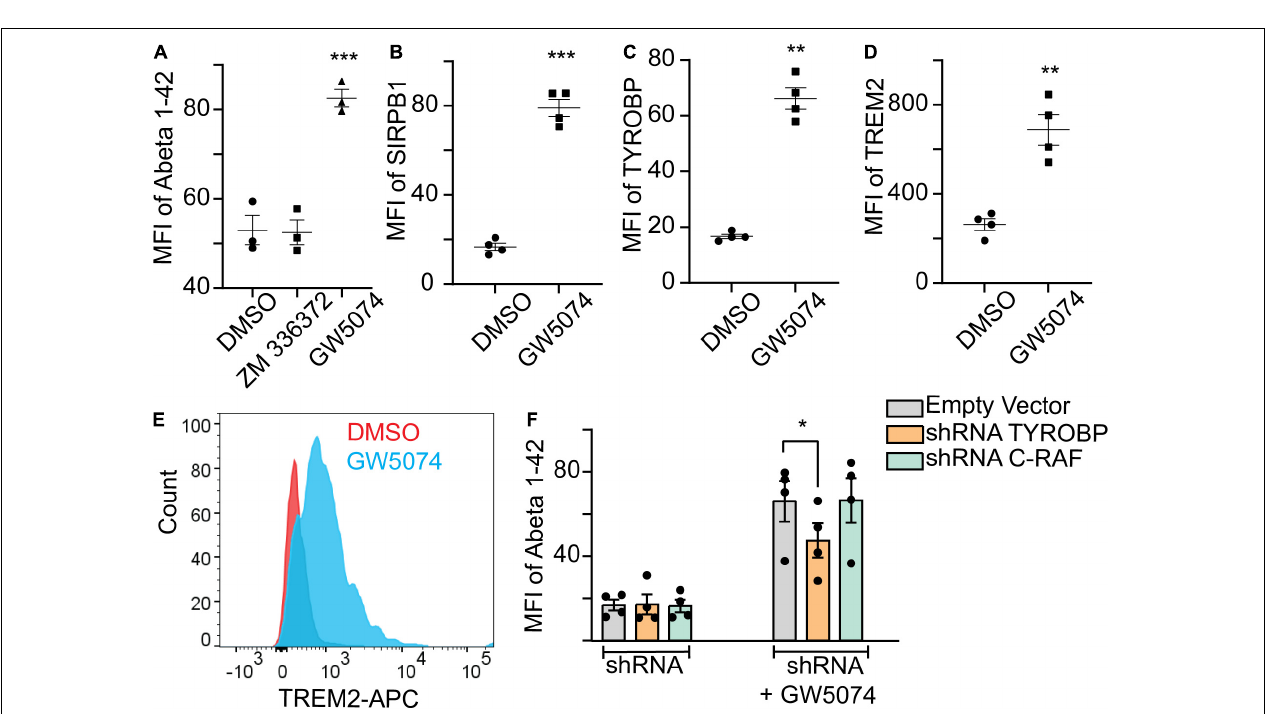
FIGURE 4 | GW5074 upregulates SIRP β 1, TYROBP, and TREM2 protein expression. Monocytes were seeded into a 96 well plate and differentiated to MDMi for 10 days. (A) 100 µ M ZM336372 treatment does not increase the Abeta1–42 uptake suggesting the phagocytosis may be mediated through a c-RAF independent pathway. GW5074 (100 µ M) increases the uptake significantly. (B,C) Cells were treated with 100 µ M GW5074 for 24 h. Cells were stained intracellularly for TYROBP and extracellularly for SIRP β 1 followed by imaging on the Celigo Imaging Cytometer. (D) For TREM2 cells were stained extracellularly and quantified using flow cytometry. (E) Representative histogram of TREM2 staining via flow cytometry. (F) GW5074 had reduced Abeta1–42 uptake when TYROBP is knocked down (using construct 3; Supplementary Figure 2 ) by using lentivirus mediated targeted shRNA, suggesting GW5074 is working through TYROBP signaling to facilitate A β 1–42 uptake. The knockdown of c-RAF (construct 3) does not have any effect on A β 1–42 uptake in the presence of GW5074, suggesting the uptake mechanism is not dependent on the c-RAF pathway. Data is expressed as mean percent change compared to DMSO control. Data were analyzed using Student’s t -test. * p < 0.05, ** p < 0.01, *** p < 0.001. Each dot represents individual subjects.